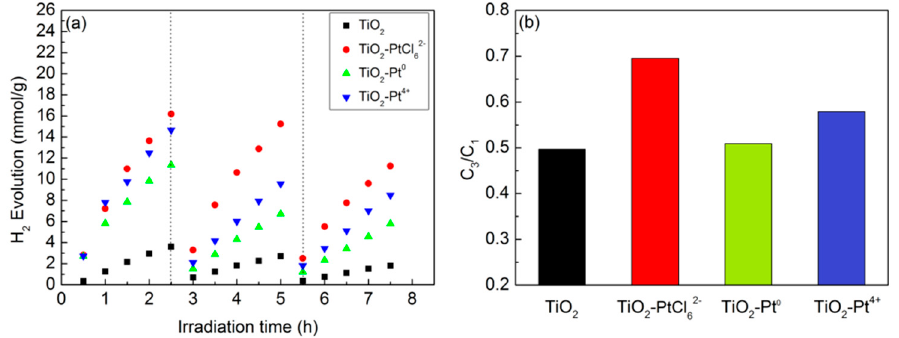
Figure 1. ( a ) Recycle experiments on TiO 2 , TiO 2 -Pt 0 , TiO 2 -PtCl 62 − and TiO 2 -Pt 4 + ; ( b ) The ratios of the third cycle activity to the first one of TiO 2 , TiO 2 -Pt 0 , TiO 2 -PtCl 62 − and TiO 2 -Pt 4 + (C 3 is the third cycle activity and C 1 is the first cycle activity).